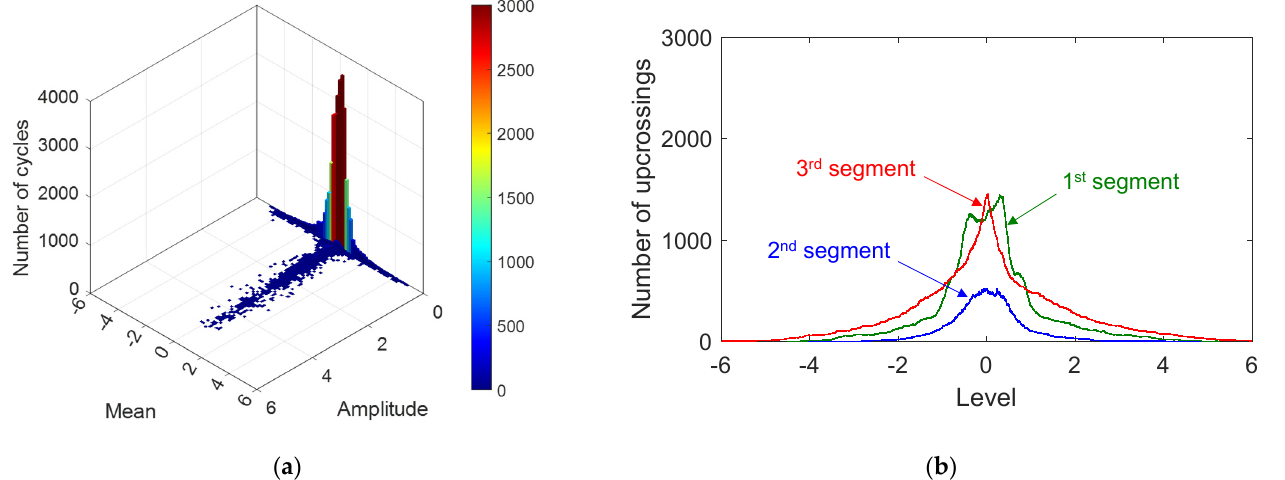
Figure 12. CH4 record, inner rim: ( a ) Rainflow matrix; ( b ) level-crossing spectrum. Amplitude, mean and level are normalized to signal standard deviation.